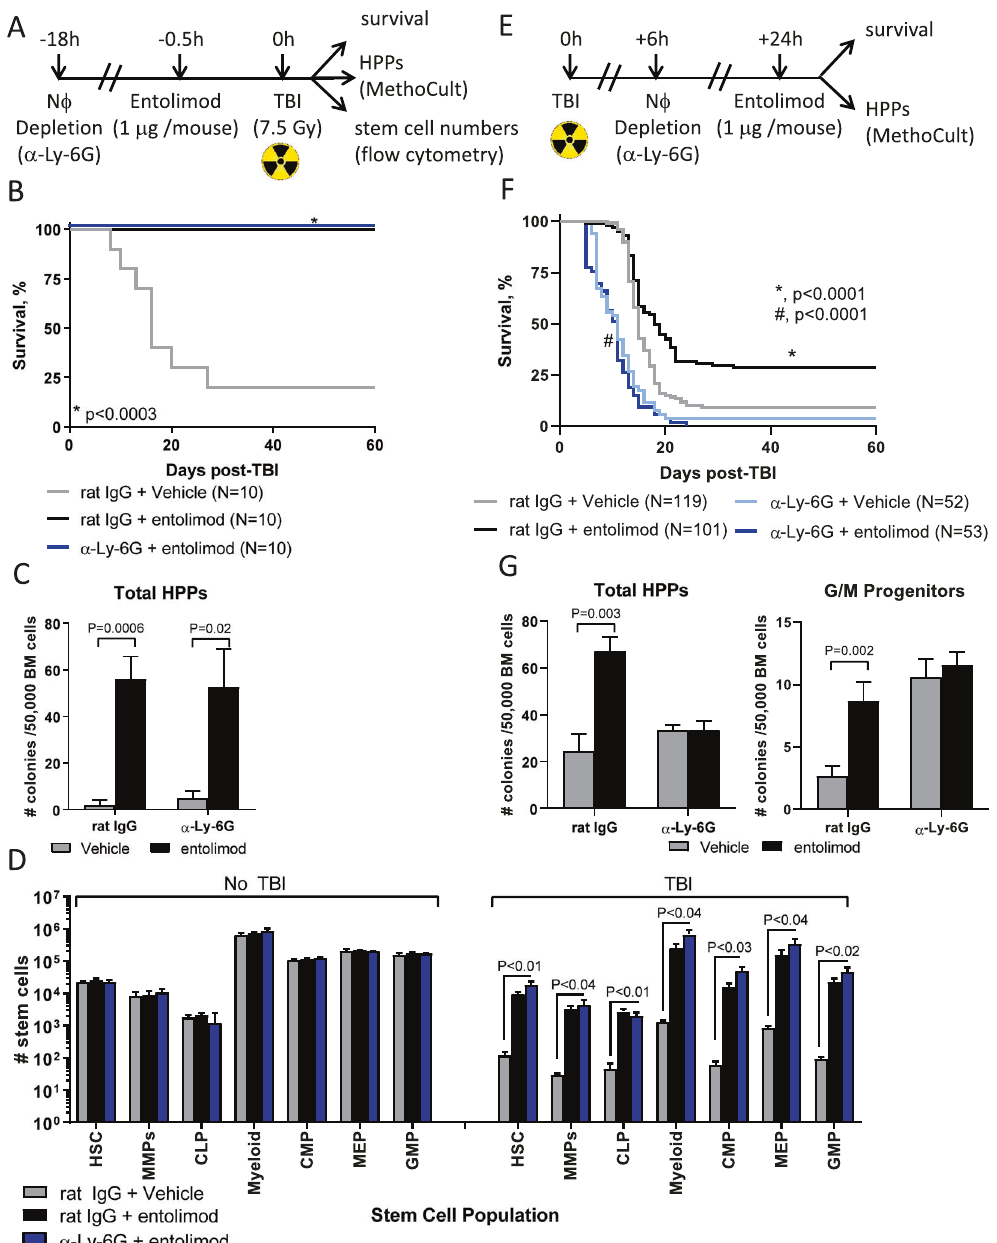
Fig. 1 N ϕ mediate the radiomitigative but not radioprotective abilities of entolimod. Experimental layouts to determine the role of N ϕ in the A radioprotective and E radiomitigative effects of entolimod in BALB/c mice. Survival by Kaplan – Meier curves in mice treated with entolimod in the presence (rat IgG) or absence ( α -Ly-6G) of N ϕ in the B radioprotective and F radiomitigative schemes. P -values were determined by Log-rank test. Measurement of total HPPs and granulocyte/macrophage (G/M) progenitors in BM by MethoCult in the C radioprotective ( n = 4 – 5 mice /group) and G radiomitigative ( n = 3 – 10 mice/group) schemes. Total HPPs were measured + 1 h post-TBI for radioprotection and for radiomitigation, both total HPPs and G/M progenitors + 3d post-treatment with vehicle or entolimod. D Absolute number of stem cell populations in BM by fl ow cytometry in the presence (rat IgG) and absence ( α -Ly-6G) of N ϕ on day 8 post-TBI in the radioprotection scheme ( n = 3 – 5 mice/group). Stem cell populations were de fi ned as follows: HSC (Lineage − Flt3 − c-kit + Sca-1 + ), MMP (Lineage − Flt3 + c-kit + Sca-1 + ), CLP (Lineage − Flt3 − IL-7R + c-kit + Sca-1 + ), Myeloid (Lineage − Flt3 − IL-7R − c-kit − Sca-1 − ), CMP (Lineage − Flt3 − IL-7R − CD34 + CD16/32 − ), MEP (Lineage − Flt3 − IL-7R − CD34 − CD16/32 − ), and GMP (Lineage − Flt3 − IL-7R − CD34 + CD16/32 + ). Error bars represent mean ± SEM; P -values were determined by Student ’ s t -test.